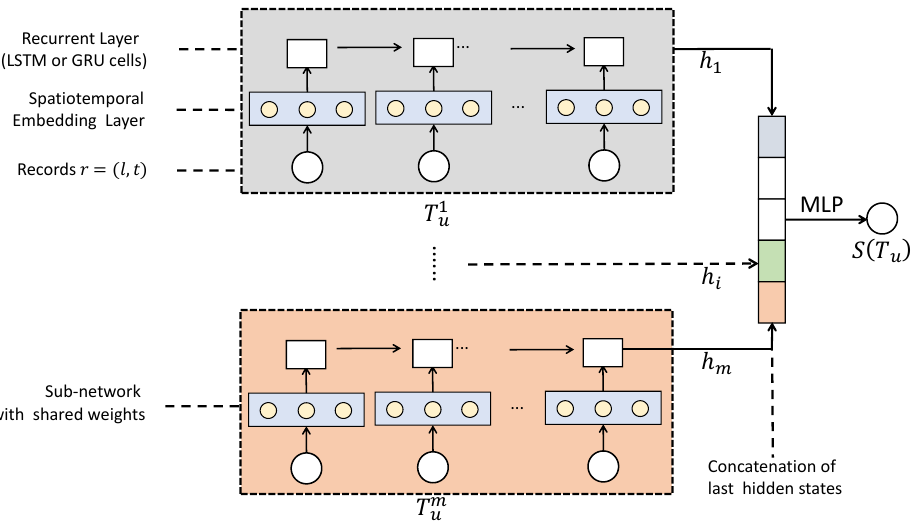
Figure 4. Detailed architecture of the calibration network, taking T u = T 1 u T 2 u . . . T m u as input and returning a score S ( T u ) to represent its data